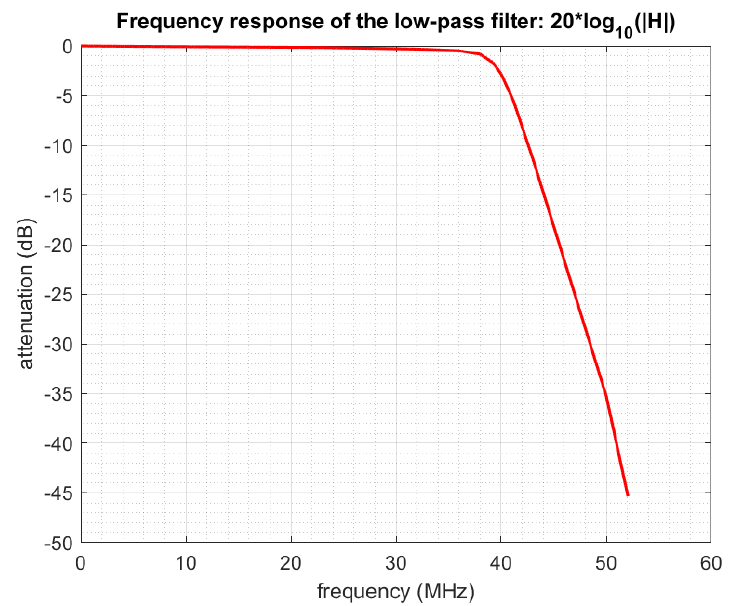
Figure 5. Frequency response of the low-pass filter.